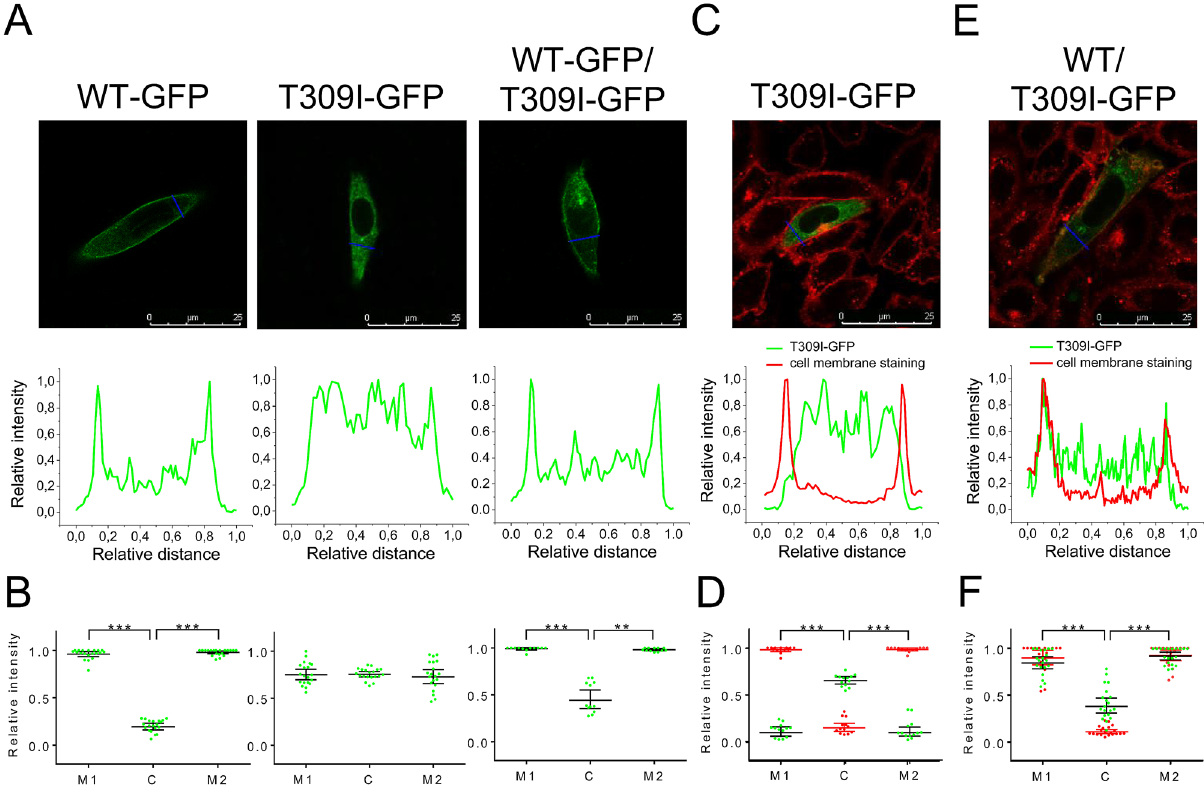
Figure 4. Subcellular localization of WT- and T309I-Kv7.1 subunits expressed in CHO cells (KCNE1 subunit cotransfected). ( A ) Confocal microscopic images of representative cells expressing WT-GFP ( i.e. tagged with GFP at the C-terminal end), T309I-GFP, or both WT-GFP and T309I-GFP subunits (upper panels), and respective relative fluorescence intensity profiles (lower panels) under the blue lines in the upper panels; scale bar 25 µm. ( B ) The resulting maximal relative fluorescence intensity at the cell membrane (M1 and M2) and its mean value in the cytosol ( C ) in all investigated cells ( n = 20, 20 and 12 in WT-GFP, T309I-GFP and WT-GFP/ T309I-GFP subunits, respectively; cells from 4 to 7 transfections used in each variant); ** and ***statistical significance of the difference in fluorescence intensity among M1, M2 and C in the respective group of cells at P < 0.01 and 0.001, respectively. ( C , E ) Subcellular localization of the T309I-GFP subunits, either expressed alone ( C ) or co-expressed with non-tagged WT (no GFP; E); the cell membrane was stained with red fluorescent dye. Representative cells (upper panels) and respective relative fluorescence intensity profiles (lower panels) under the blue lines in the upper panels of the GFP signal (green lines) and of the membrane staining signal (red lines; both at the cell cross-sections indicated by the blue lines in the upper panels). ( D , F ) The resulting maximal relative fluorescence intensities of both GFP and membrane staining fluorescence (green and red dots, respectively) at the cell membrane (M1 and M2) and their mean values in the cytosol (C) in all investigated cells ( n = 13 and 20 in D and F, respectively; cells from 3 and 7 transfections used); ***statistical significance of the difference in fluorescence intensity among M1, M2 and C at P < 0.001. Figure 4A,C, E were prepared using the software LAS X, version 3.5.2.18963 (upper panels) and Origin, version 8.5.1 (lower panels), Fig. 4B,D,F using the software GraphPad Prism, version